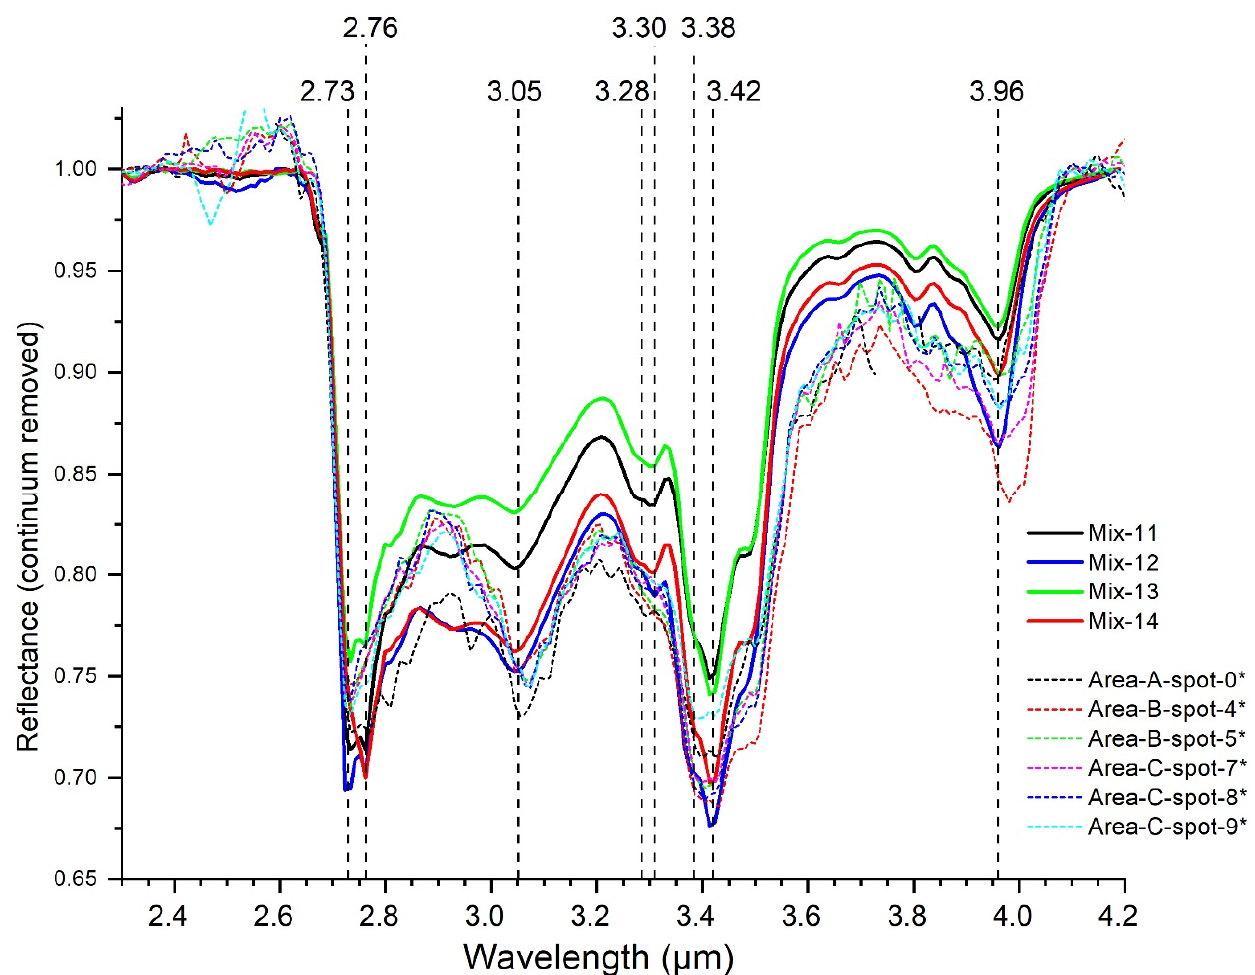
Figure 6. Reflectance spectra after continuum removal of laboratory mixtures 11-12-13-14 between 2.5–4.2 µm (solid lines) compared with carbon-rich VIR spectra (dashed lines) from Ceres in the Ernutet and Hakumyi areas (*with photometric reduction—see Methods and Analyses section). Vertical dashed lines are major bands discussed in the main text. These four mixtures present the best match with Ceres’ spectra and indicate that the surface composition in these regions can contain 20 wt.% of carbon, one third being aliphatic carbons.